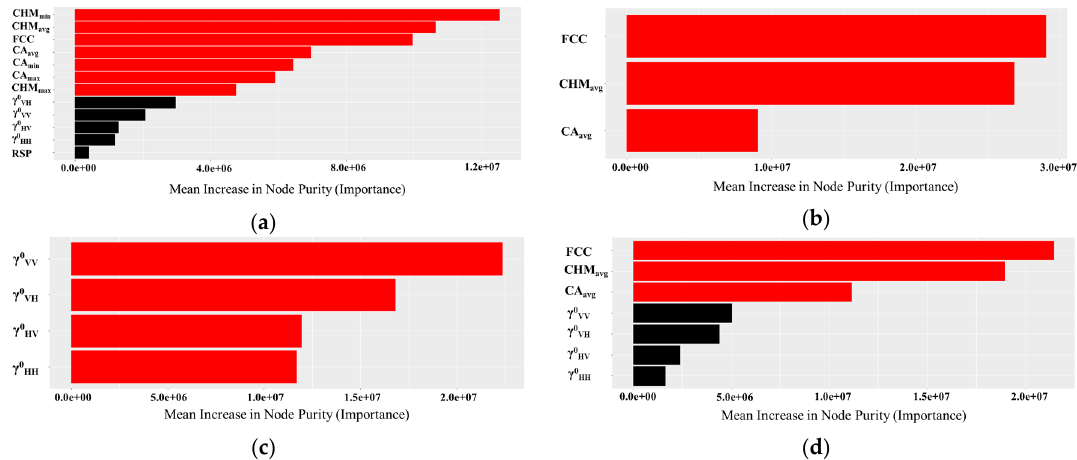
Figure 12. Importance of each variables explained as the mean increase in node purity (i.e. decrease in node impurity: Gini Index) for ( a ) Model RFR23 , ( b ) Model UAS , ( c ) Model SAR , and ( d ) Model UAS+SAR . The upper shows more influential variables used in the random forest model for estimating stem volume. Red color bars indicates the parameter that significantly partitioned the data.